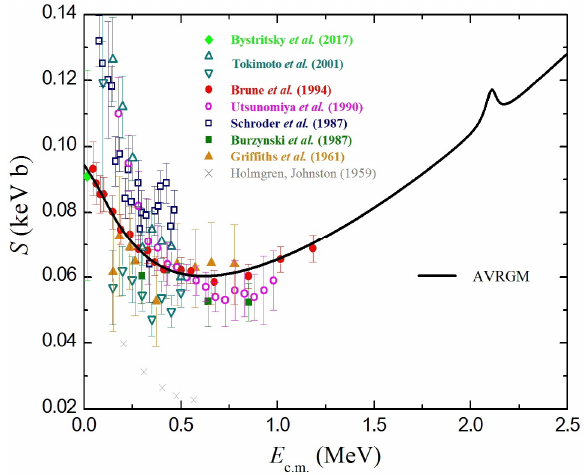
Fig. 3. Energy dependence of the 3 H( α , γ ) 7 Li total astrophysical S factor .